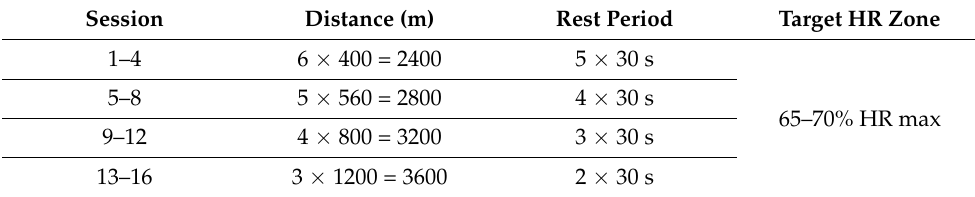
Table 2. NW training sessions based on training distance, rest period and target heart rate